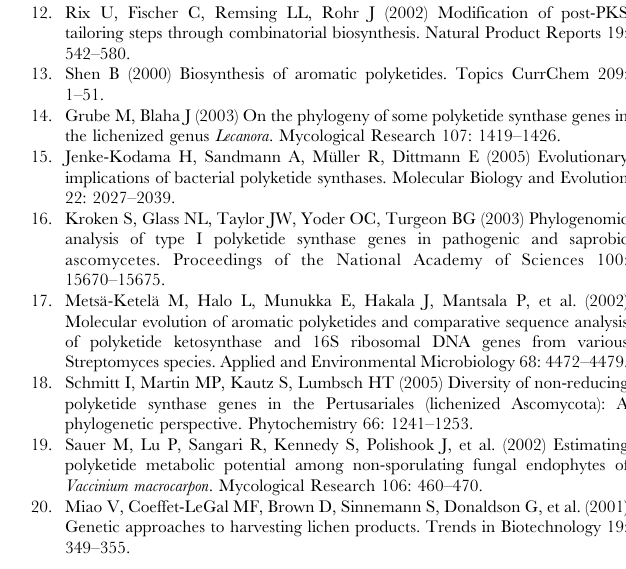
Table S1 PKS sequences from GenBank included in the alignment. All blastx hits greater 200 score bits were included (EF423780, EF423781 were used as